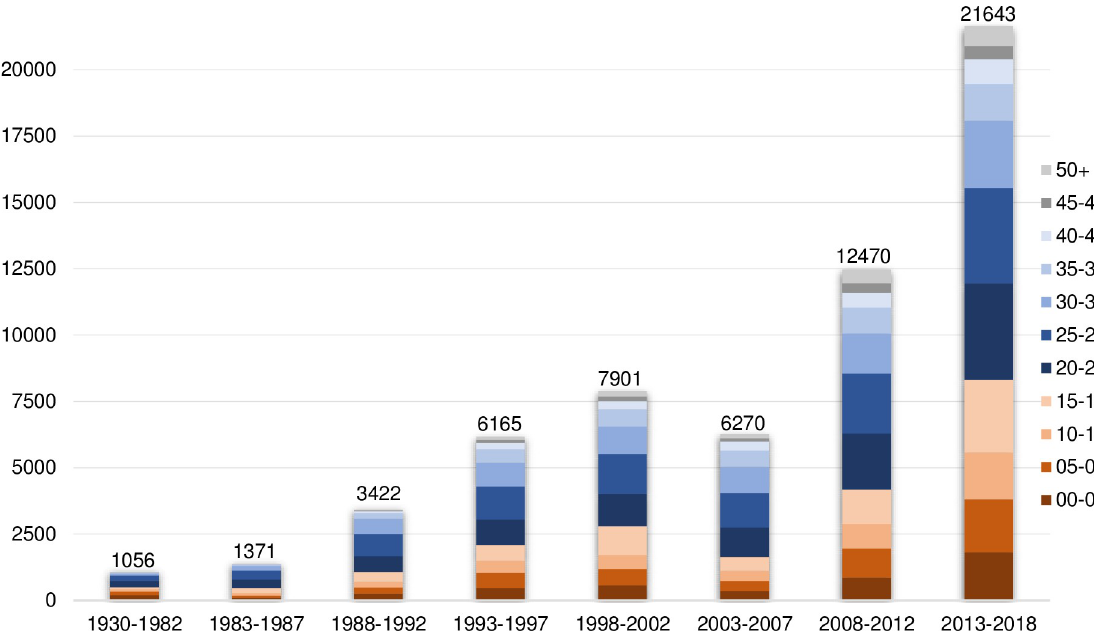
Fig 2. Number of first-generation girls and women by year of arrival and ages at the time of arrival in the Netherlands.